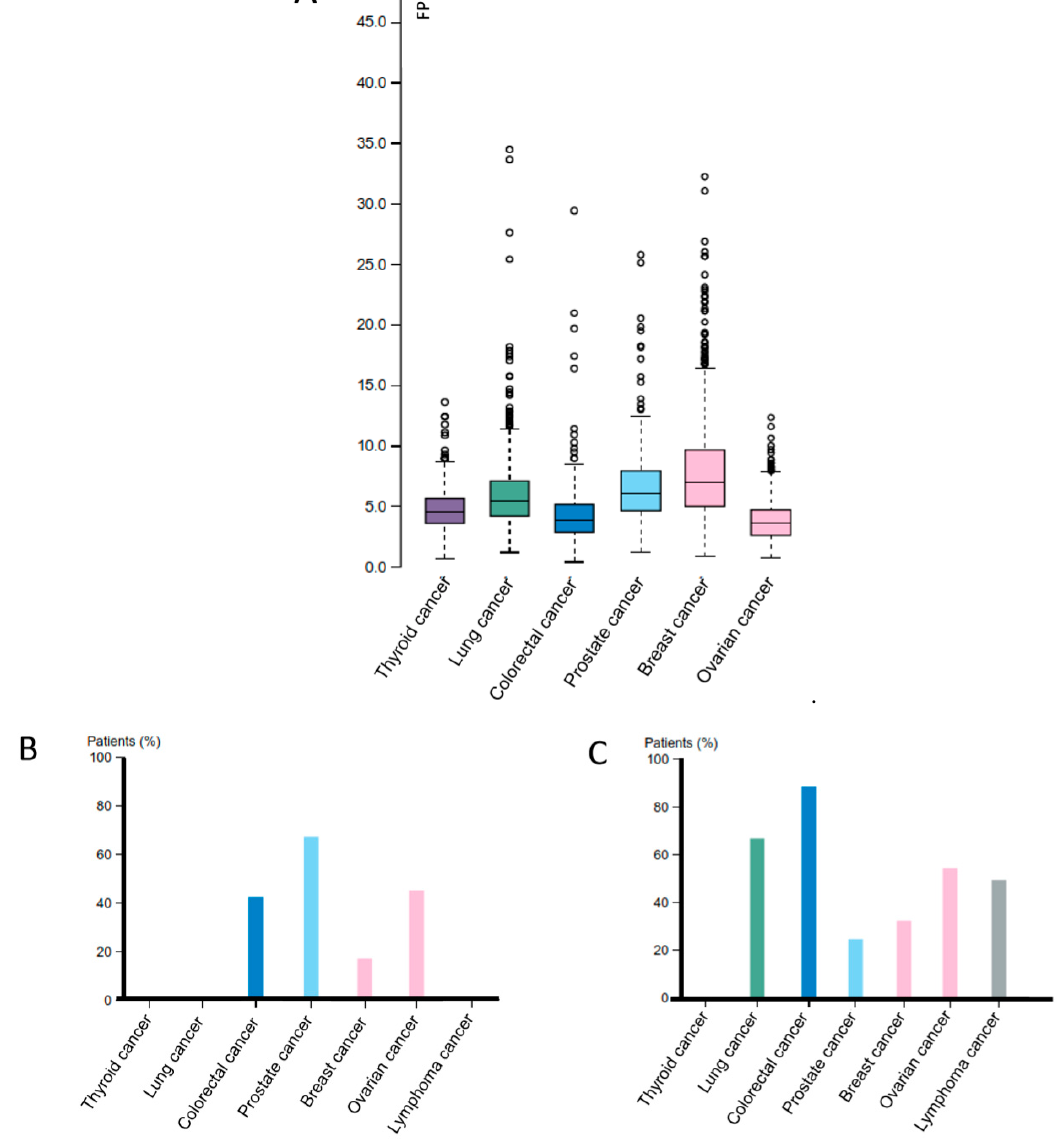
Figure 4. The Cancer Genome Atlas (TCGA)-derived expression profile of the Dicer gene in representative human cancers. Dicer expression landscaping is presented in human cancer types based on the TCGA platform (modified from TCGA). ( A ) RNA-seq data for Dicer RNA expression in thyroid, lung, colorectal, prostate, breast and ovarian cancer. The value 0.0 on the vertical axis represents zero expression of Dicer , while the value 45.0 maximum expression. ( B , C ) Dicer protein expression in thyroid, lung, colorectal, prostate, breast and ovarian cancer and lymphoma. The color bars represent the percentage of patients with medium and high protein expression levels, while the absence of a bar represents low and zero protein expression levels. The expression of the protein was evaluated with ( B ) the HPA000694 antibody (Sigma-Aldrich, St. Louis, MO, USA) and ( C ) the CAB068185 antibody (Sigma-Aldrich, St. Louis, MO, USA).